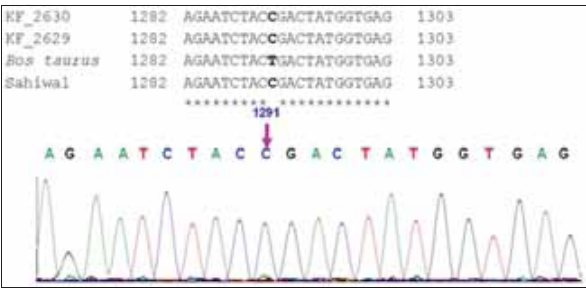
Figure-2: Chromatogram showing nucleotide change at position 1291(T>C)